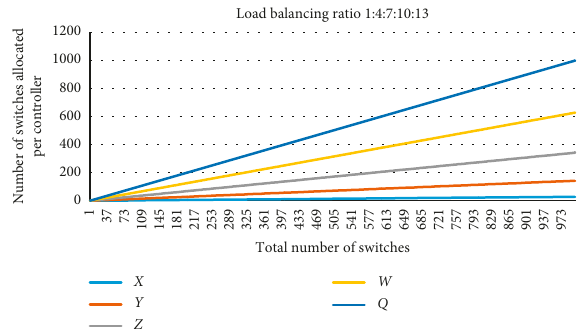
Figure 15: Load balancing for five slave controllers with ratios 1 :4: 7:10:13.